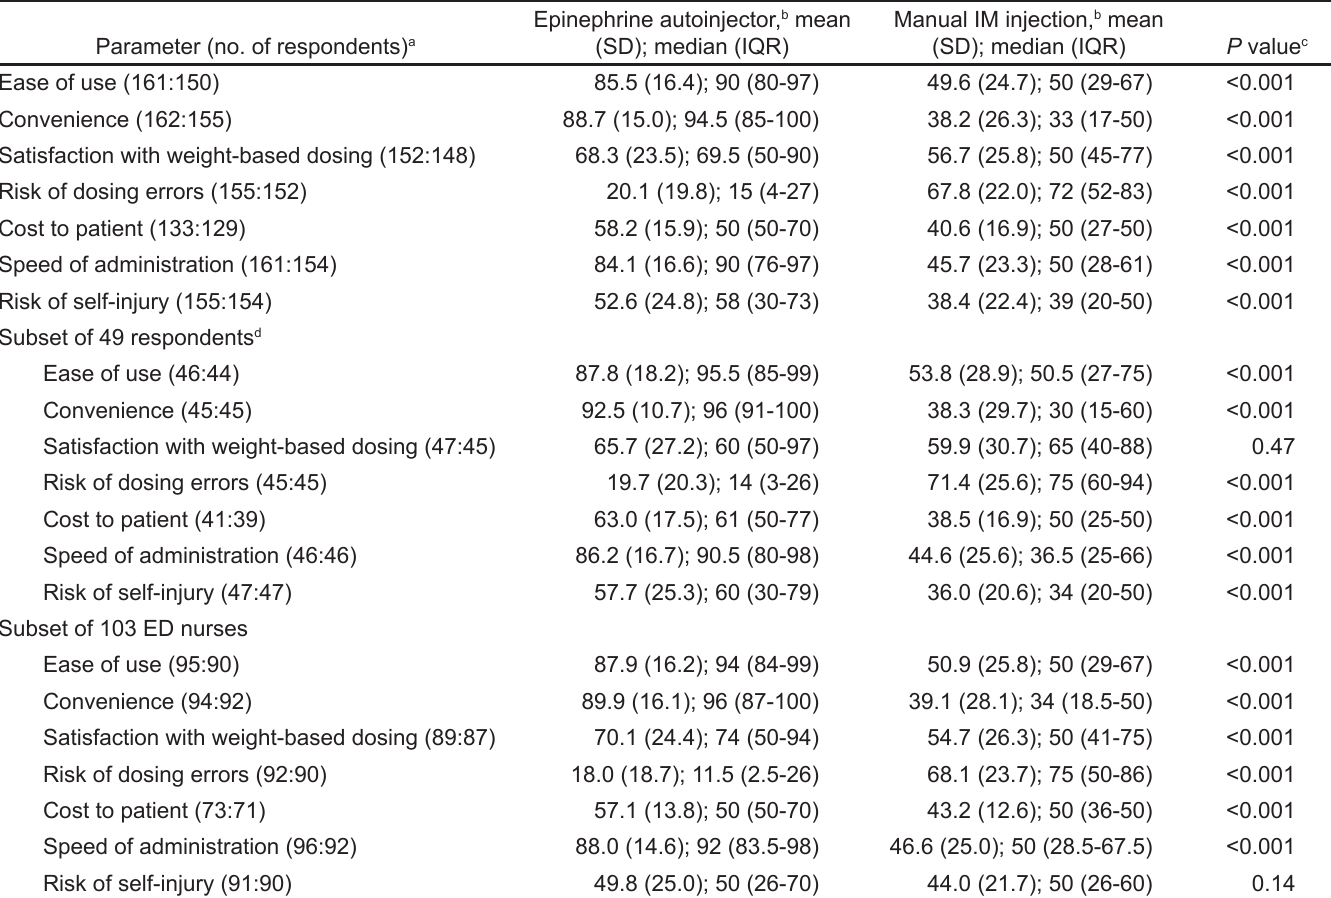
Table 2. Ratings of epinephrine autoinjector and manual intramuscular injection by 172 survey respondents a .